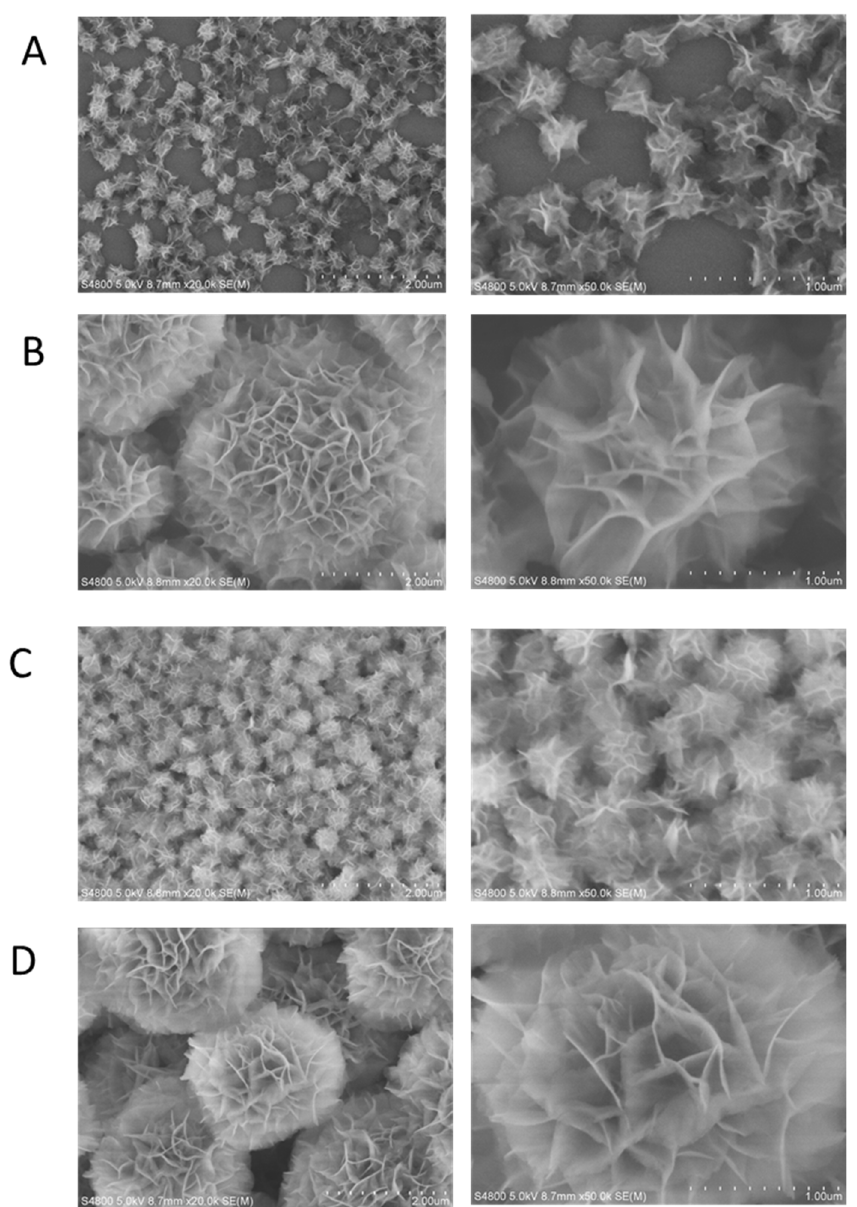
Figure 1. Microphotograph of nanoflower (magnification: left × 20,000, right × 50,000). ( A ). Prepared IRS 661 DNA nanoflower; ( B ). prepared IRS 869 DNA nanoflower; ( C ). prepared IRS 954 DNA nanoflower; ( D ). prepared CTR DNA nanoflower.